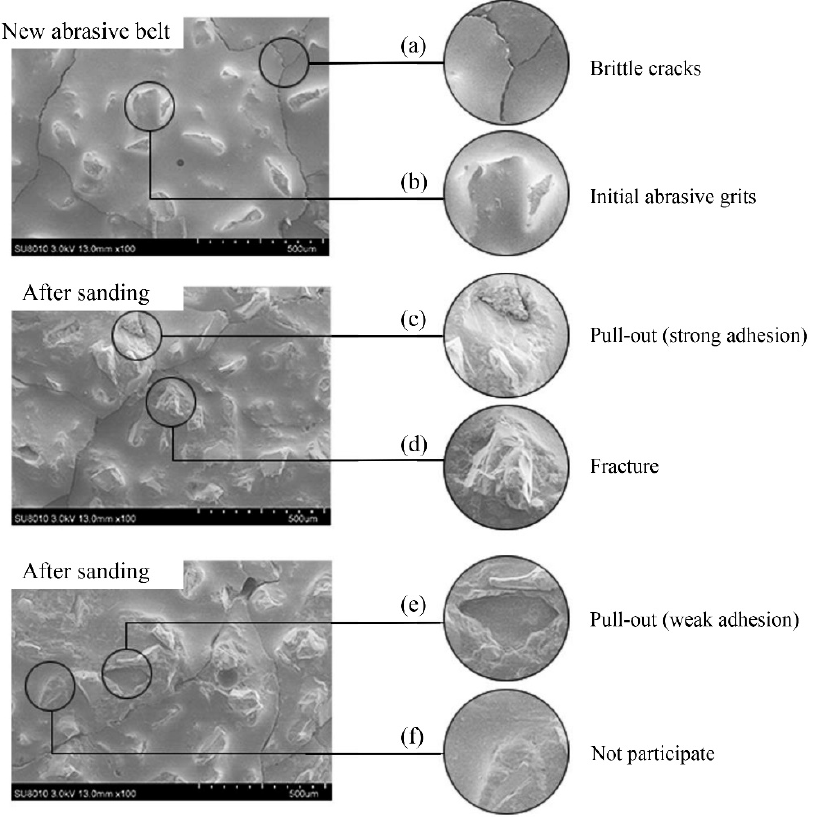
Figure 6. Typical wear behavior of abrasive-belt (P120) surface before and after MDF sanding through SEM observation. ( a ) brittle cracks in the adhesive coating; ( b ) initial abrasive grits wrapped in adhesive; ( c ) pull-out of abrasive grits with strong adhesion; ( d ) broken abrasive grits; ( e ) pull-out of abrasive grits with weak adhesion; ( f ) abrasive grits not participated in sanding. Poor height consistency of abrasive-grit protrusion is equal to fewer abrasive grits involved in MDF sanding. The involved grits are subjected to greater stress concentration, performing a stronger material-removal ability. However, the sanding-removal efficiency does not improve by the reason of the small number of the involved grits. The height consistency of abrasive grits also has a significant effect on surface roughness of samples, which is taken as the principal quality indicator of the sanding process [29]. In the early stage of sanding, the surface roughness value of the workpiece was relatively big. In the mid-stage of sanding, when the height consistency of the abrasive grits was better, the surface roughness value of the workpiece was small and relatively stable. When the grit wear was severe, the abrasive belt slowly lost its cutting ability. In this case, the surface roughness of the workpiece would increase and even machining defects would appear, such as surface burning [6]. Overall, the average value ( X ) for S a and S ku of P60 are both larger than that of P120 as shown in Figure 7, while the standard deviation ( σ ) for S a and S ku of P60 are both smaller than that of